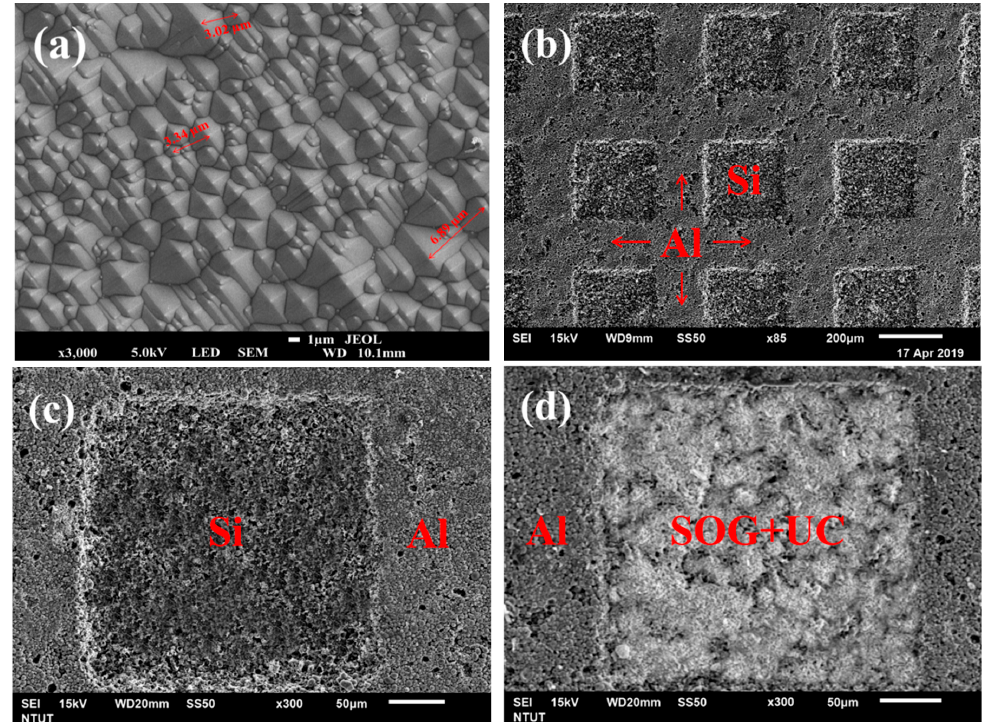
Figure 2. Top-view SEM images of ( a ) etched pyramidal surface, ( b ) etched matrix-grooves, ( c ) grooves without coating, and (d) grooves coated with the UC